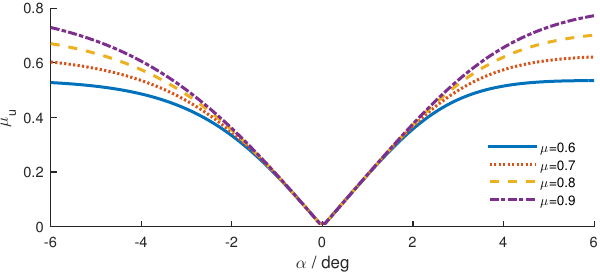
Figure 9. Tire force use ratio as a function of the slip ratio.